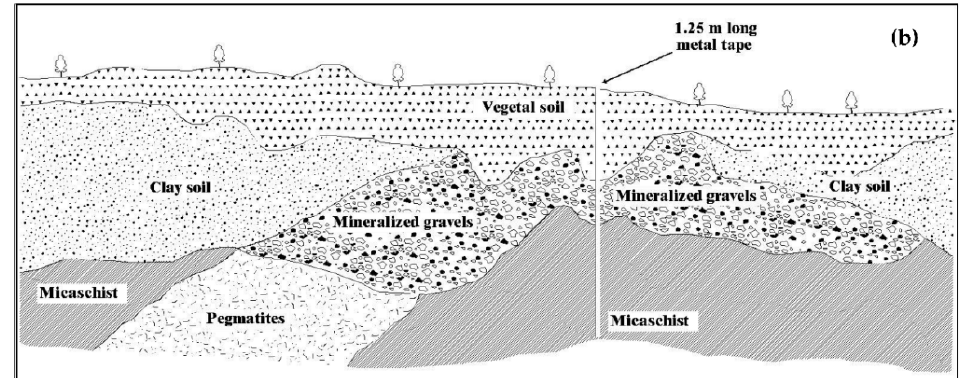
Figure 2. ( a ) Modified geodynamic model for the placement of columbite ‐ tantaliferous pegmatites and associated rocks of Issia [30] (p. 273). ( b ) Modified general architecture of a weathering mantle within a studied Nb ‐ Ta placer deposit [30] (p. 196). Original figure from [30] has been modified with the consent of its author.